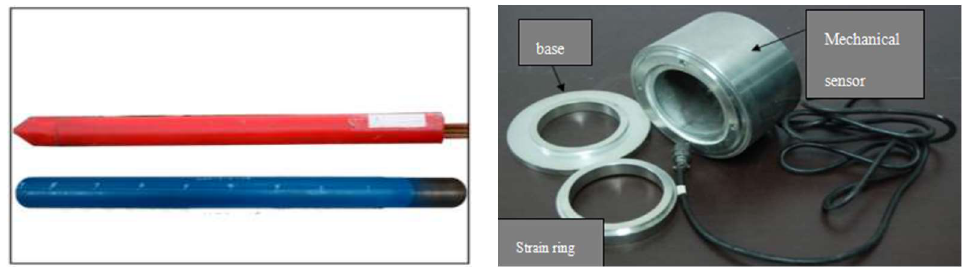
Figure 3. Sensors for measuring force and deformation. Table 2. Technical parameters of NPR cable.